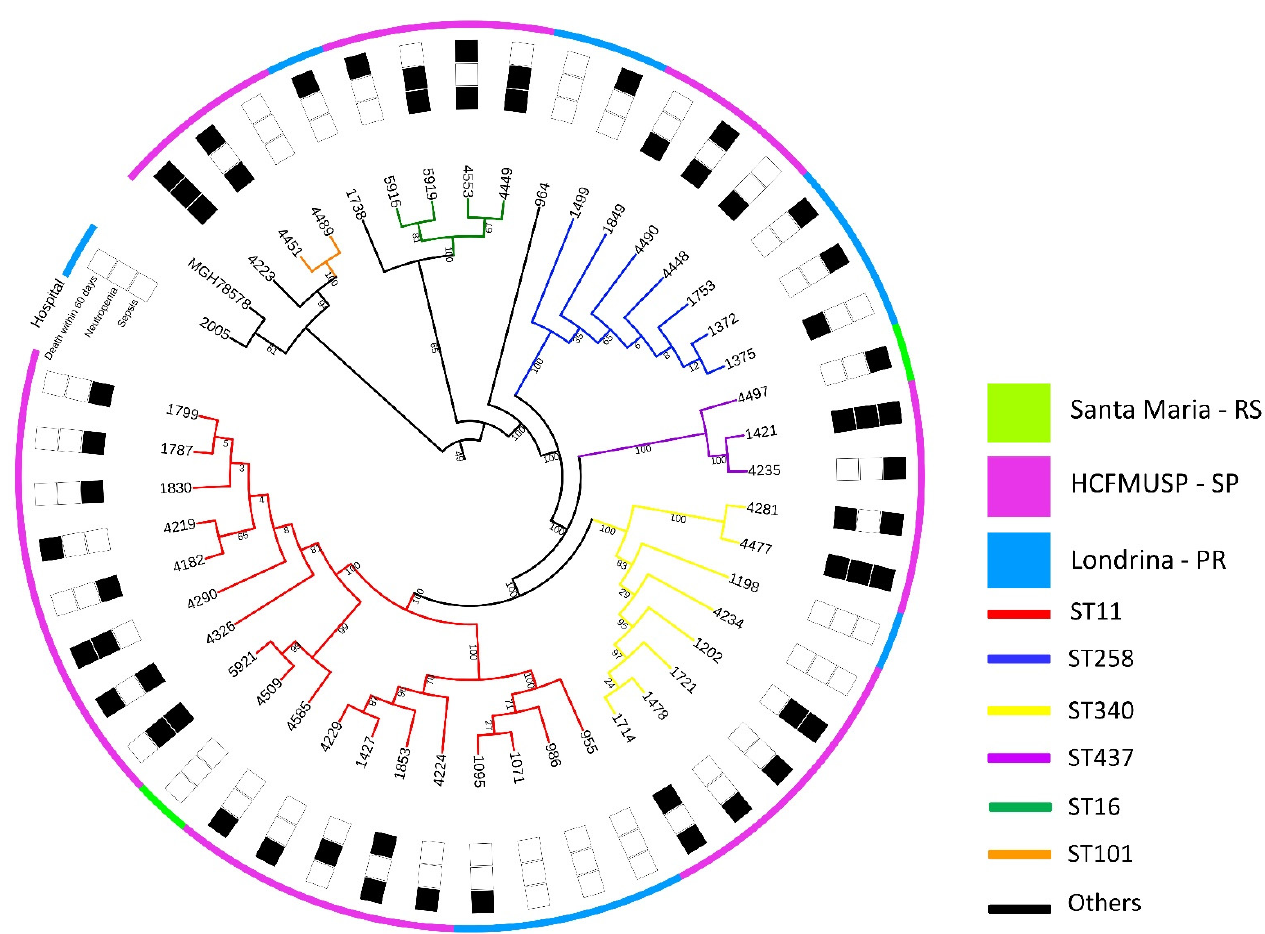
Figure 1. Phylogenetic tree of all 46 K. pneumoniae isolates in this study, based on single-nucleotide polymorphisms (SNPs) of core genome. Colors on the outermost circle represent place of origin, while branch colors represent sequence types. Each number represents one strain, with each isolated from a different patient.